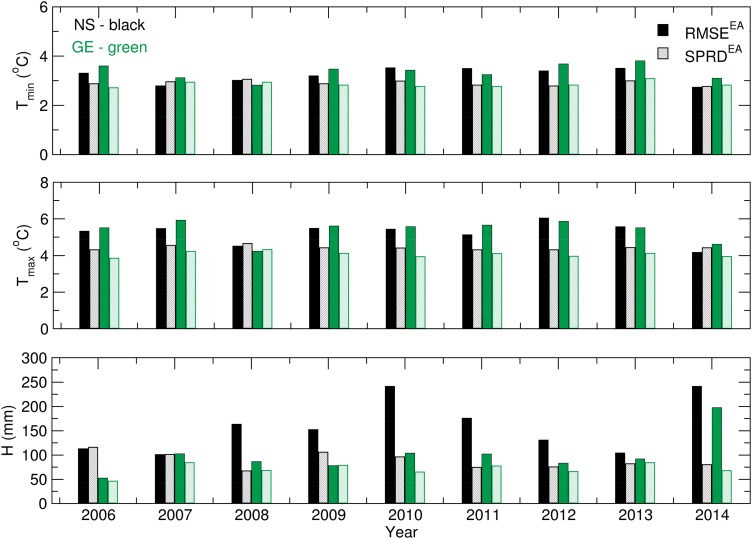
Tmin, Tmax and P for 1 March–31 August: RMSEEA and SPRDEA values for 2006–2014.